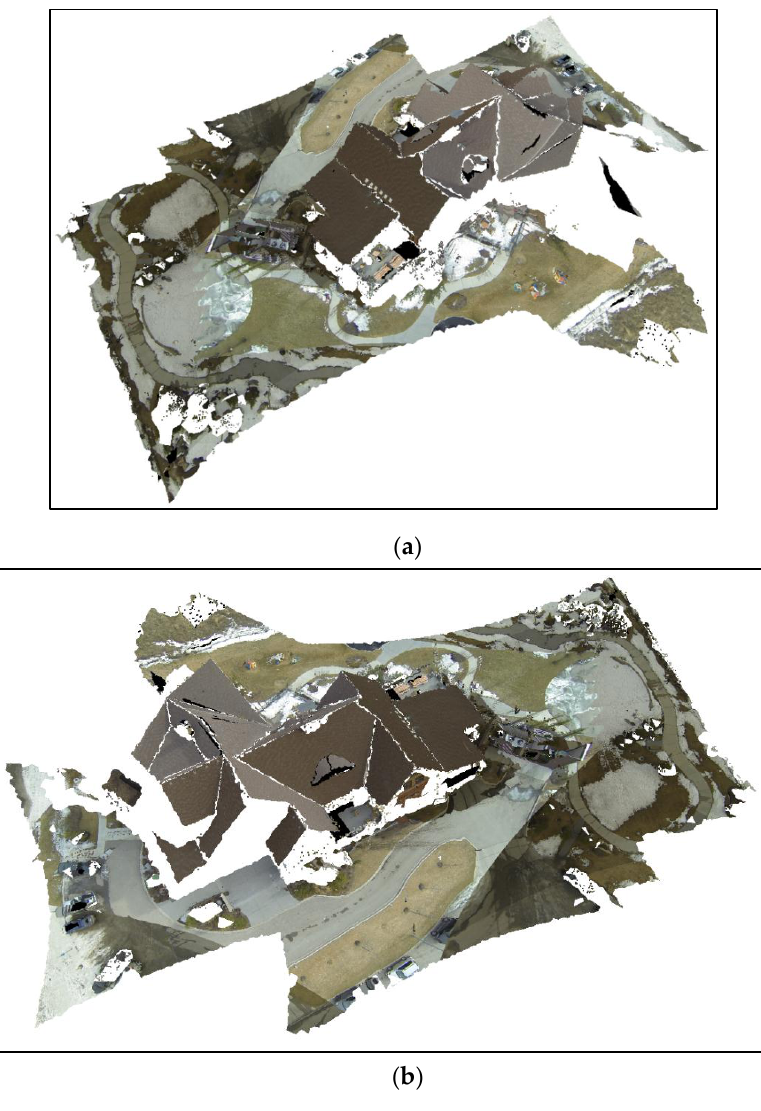
Figure 32. Realistic 3D surface reconstruction outcome for the third dataset: ( a ) and ( b ) two different views from the textured planar regions and individually colored non-segmented points.